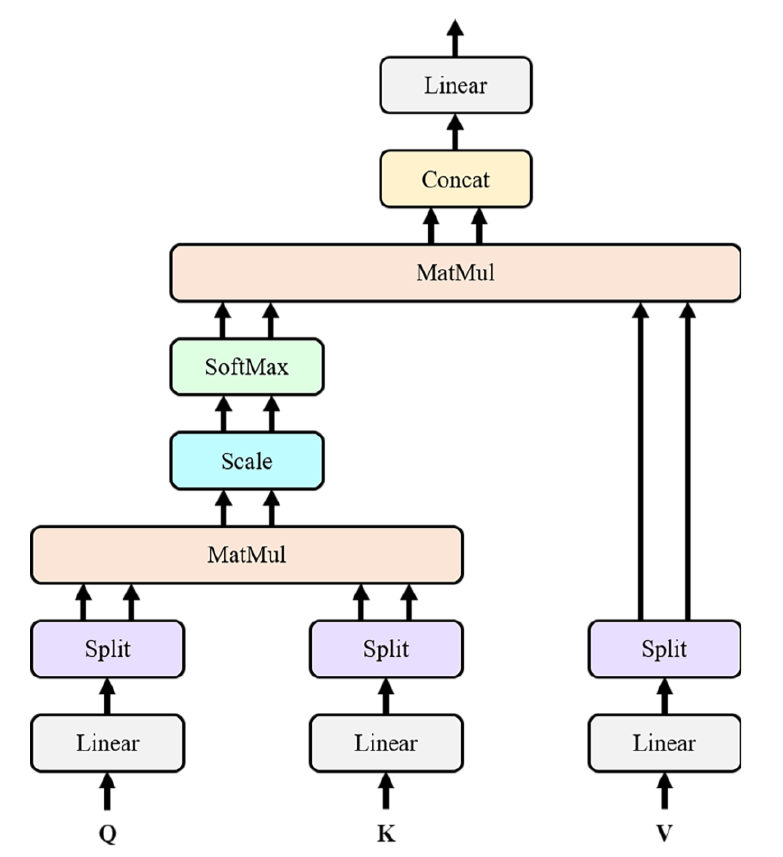
Figure 2. Diagram of the multi-head attention module.